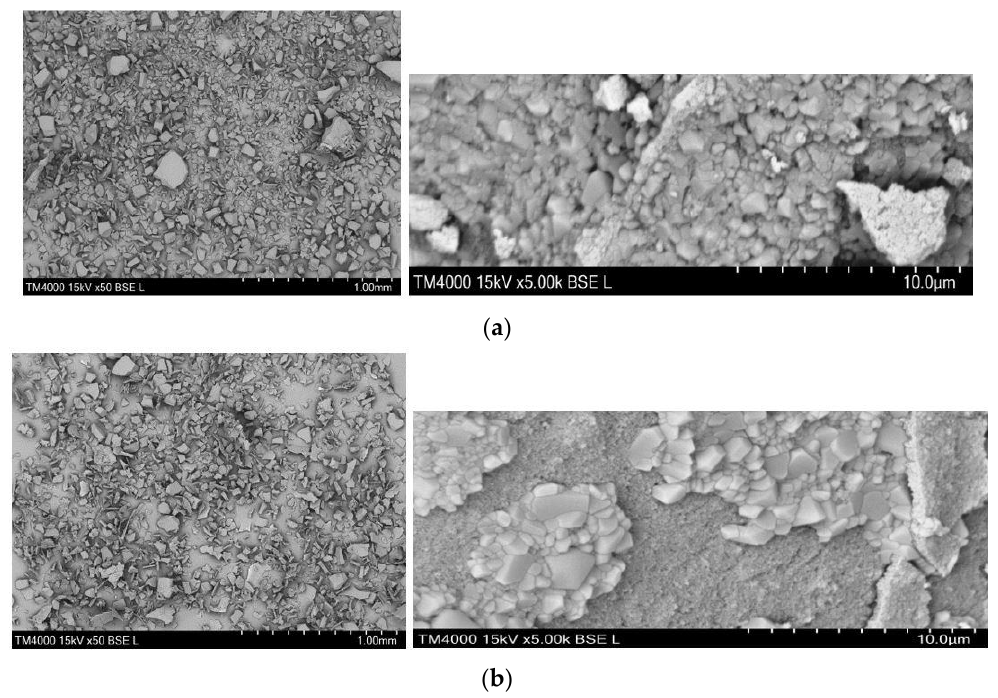
Figure 2. SEM images of ( a ) LP and ( b ) LMP at 50 and 5000 magnifications.